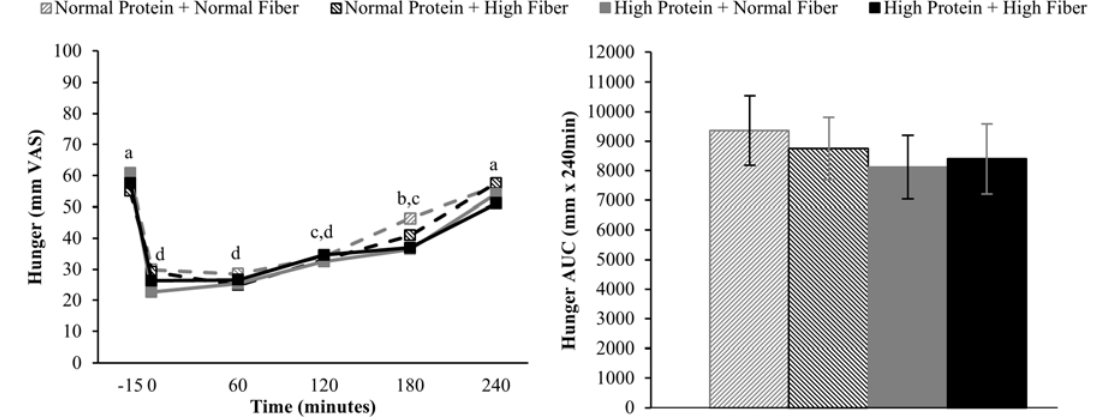
Figure 2. Postprandial time course ( left ) and area under the curve (AUC) ( right ) for hunger on the four testing days. Postprandial time points with different letters are statistically different (main effect of time, Tukey-adjusted p < 0.05).